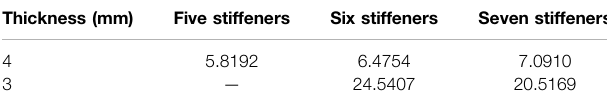
TABLE 8 | Decrease in maximum stress due to increase in unit mass (MPa/Kg).